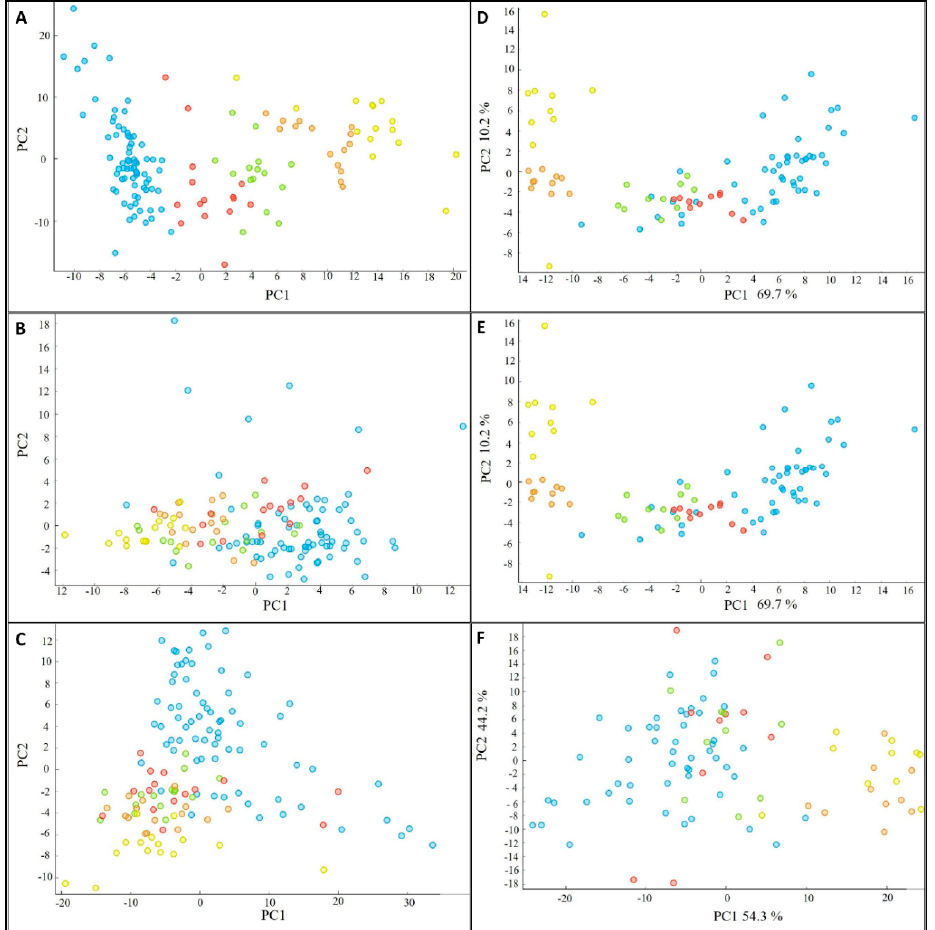
Figure 3. PCA scatter plots of FTIR ‐ ATR spectra of fermented bioproducts obtained from the SSF of cornmeal ‐ based and wheat bran ‐ based substrates supplemented with animal fat at concentrations (blue) 0%, (red) 5%, (green) 10%, (orange) 20% and (yellow) 30%. ( A )—lipid region of cornmeal ‐ based fermented substrates, ( B )—protein region of cornmeal ‐ based fermented substrates, ( C )—polysaccharide region of cornmeal ‐ based fermented substrates, ( D )—lipid region of wheat bran ‐ based fermented substrates, ( E )—protein region of wheat bran ‐ based fermented substrates, ( F )—polysaccharide region of wheat bran ‐ based fermented substrates.